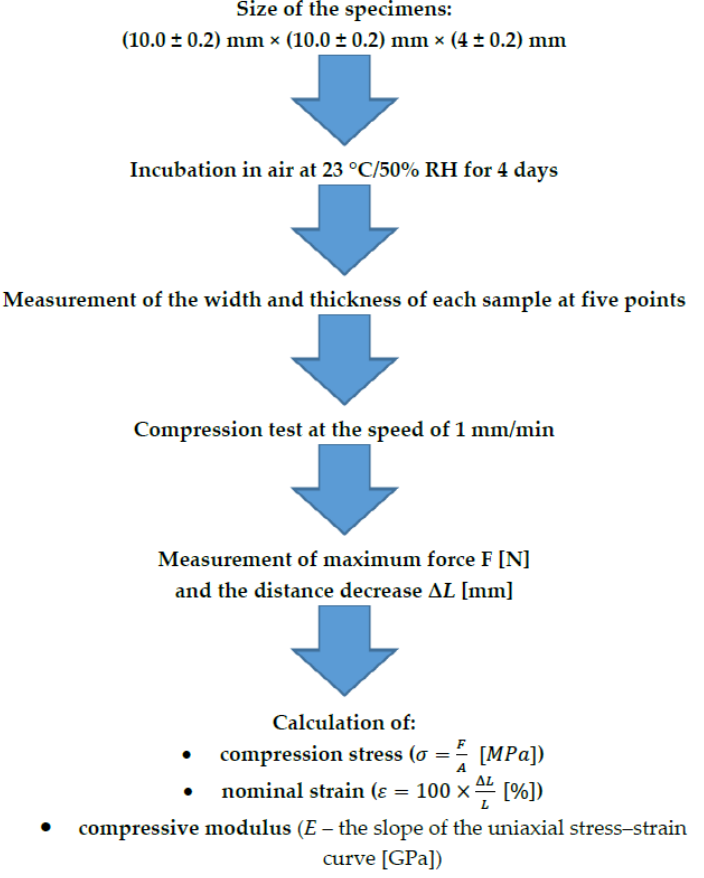
Figure 1. Axial compression test according to the PN-EN ISO 604:2003 standard ( F , force (N); A , initial cross-sectional area measurement (mm 2 ); L , measurement of the distance between compression plates (mm); ∆ L , decrease in distance between the plates (mm)).